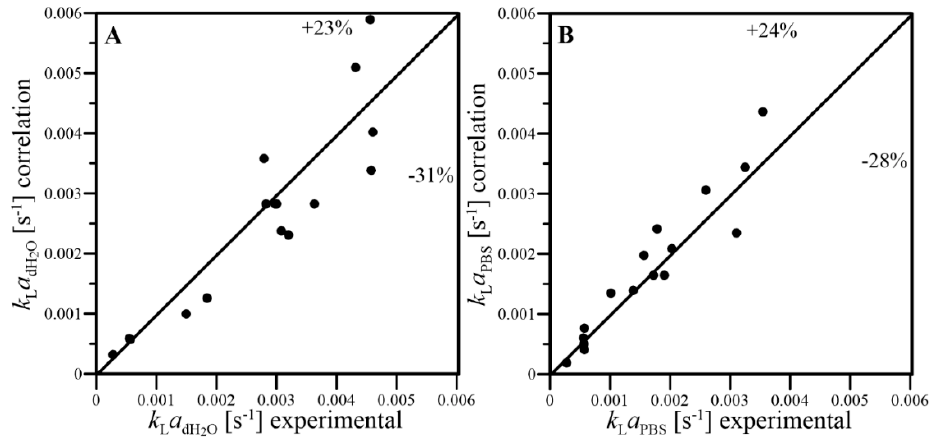
Figure 7. Parity plots of the values of 𝑘 L 𝑎 dH lations (13) and (14),